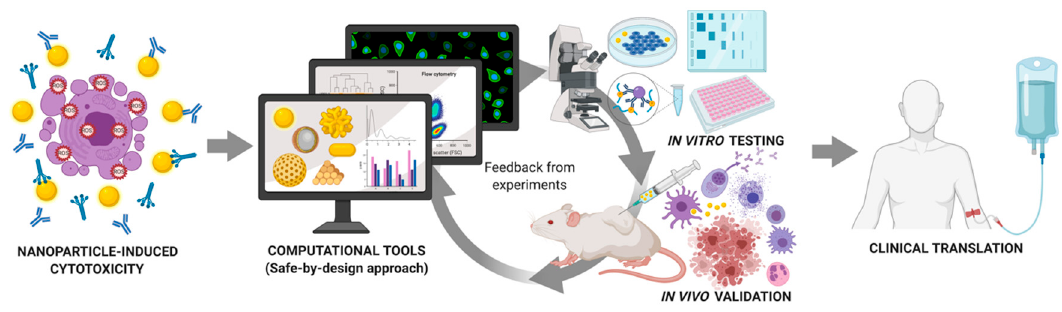
Figure 6. Data driven safe-by-design approach to tailor nanoparticle review for nanomedicine. Created with BioRender.com.